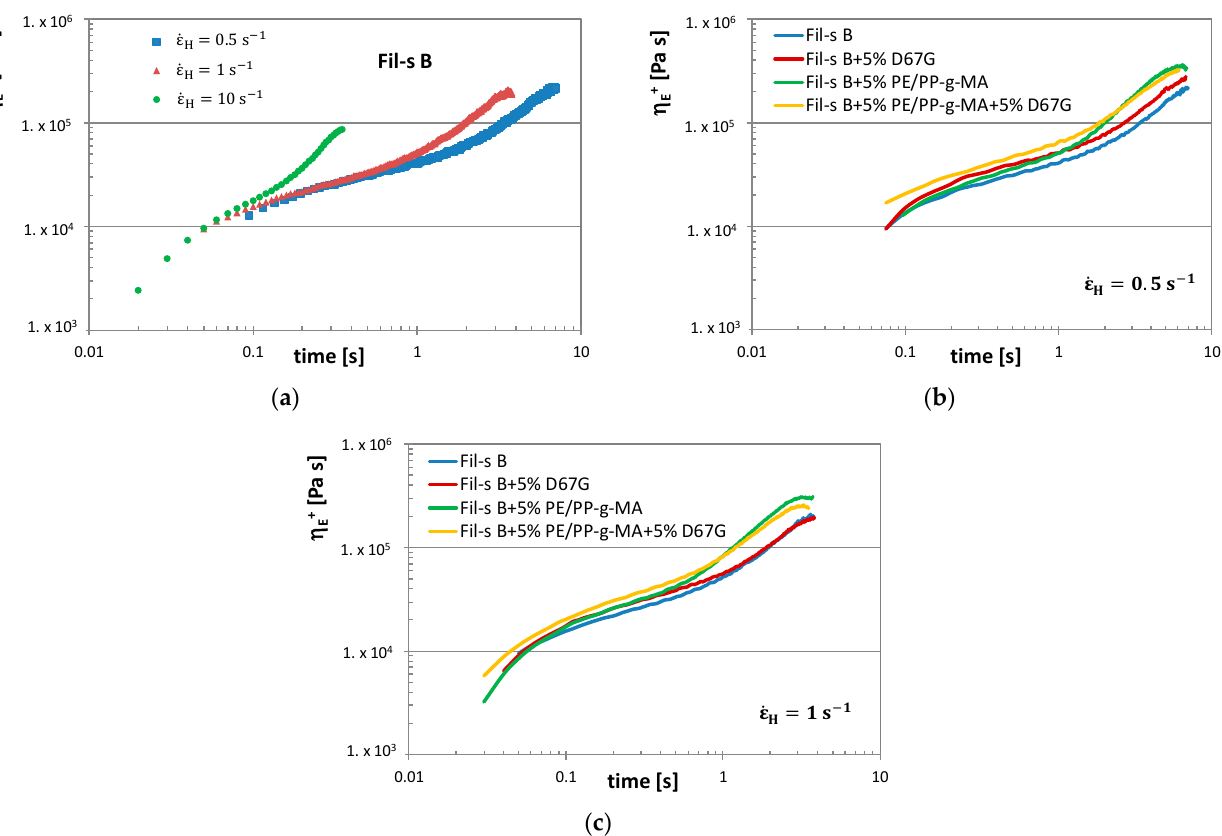
Figure 8. Tensile stress growth coefficient η E+ plots as a function of time at 190 °C and ε (cid:2892) (cid:4662) = 1 s − 1 for Fil-s A and Fil-s B.